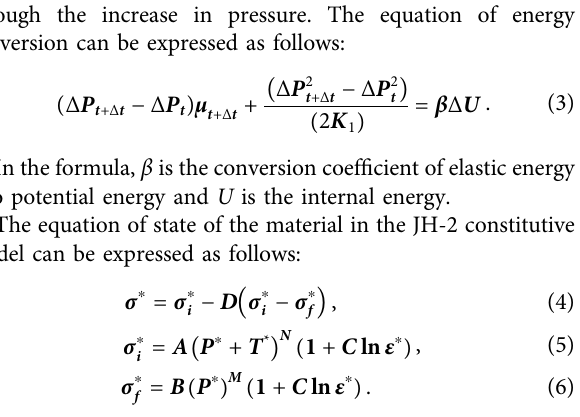
Frontiers in Materials |